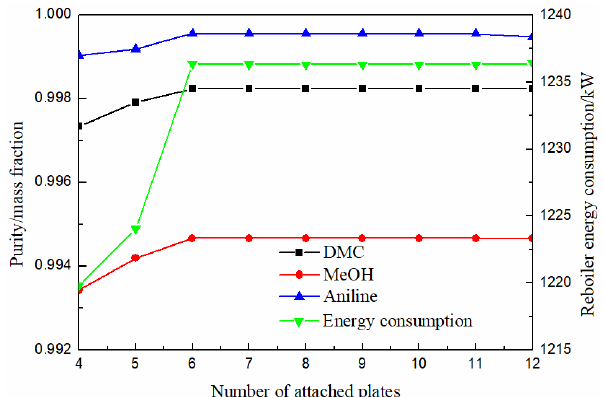
Figure 8. Effect of numbers of attached plate on products purity and heat duty of reboiler.